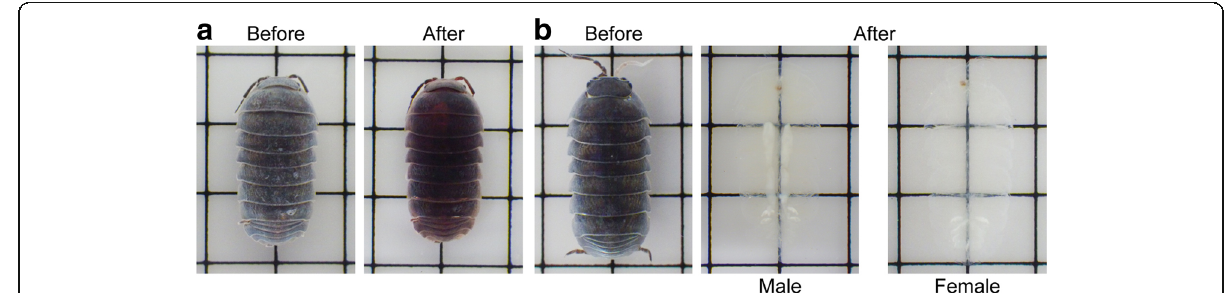
Fig. 1 Whole-mount clearing of the terrestrial isopod, A. vulgare , with advanced CUBIC protocol. a A. vulgare cleared with advanced CUBIC protocol without any pretreatment. b Clearing after pretreatment, including decalcification and bleaching. Grid = 5